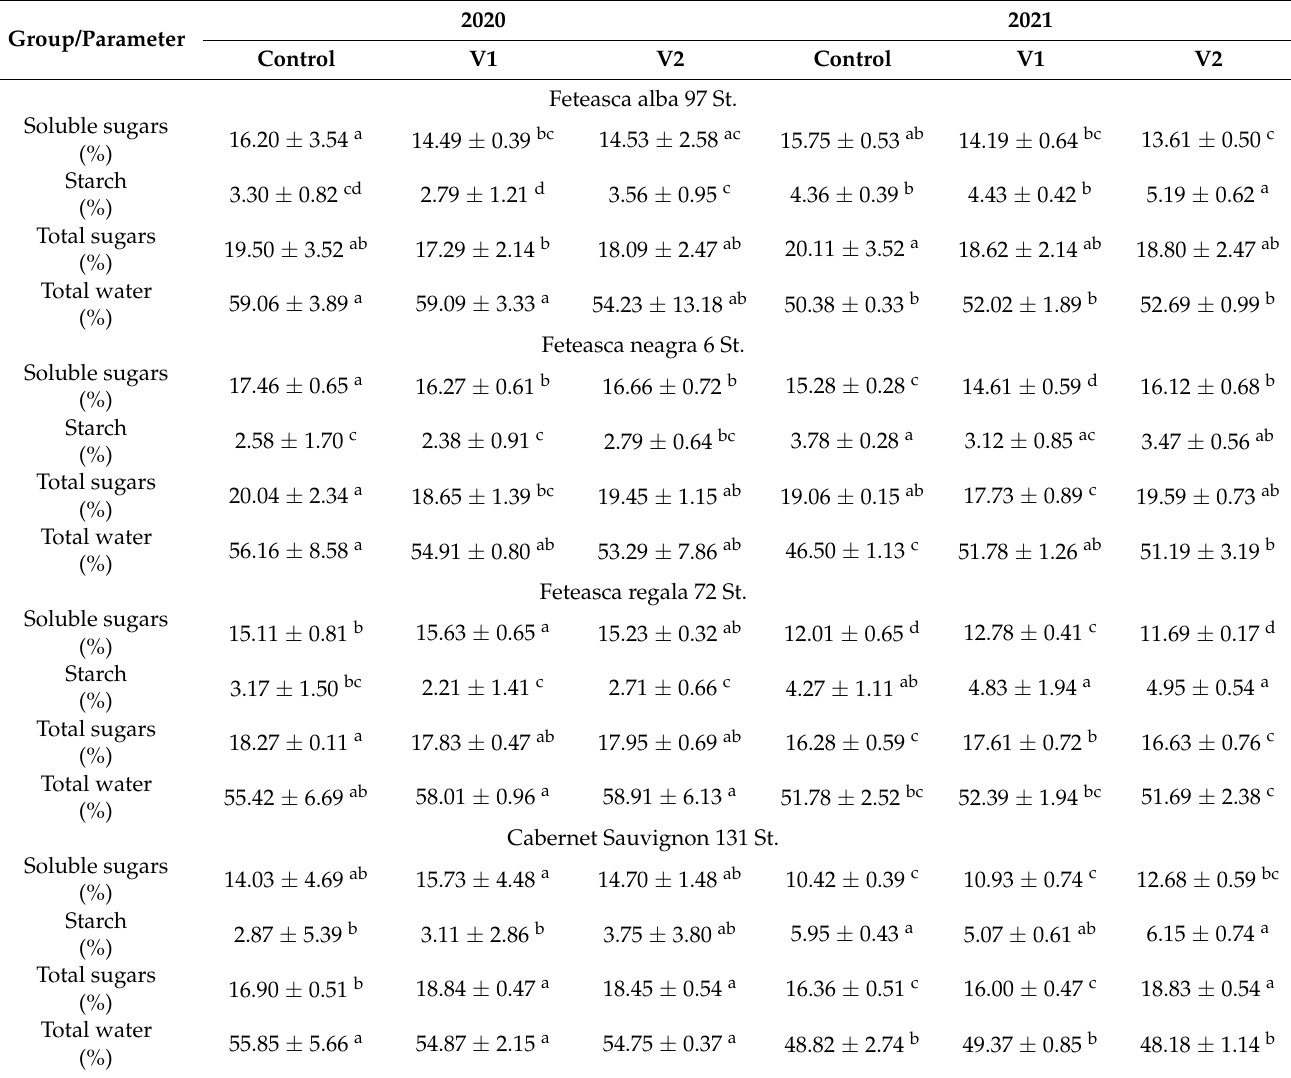
Table 3. Biochemical analyses at Feteasca alba 97 St., Feteasca neagra 6 St., Feteasca regala 72 St., Cabernet Sauvignon 131 St. plants. V1 = alcoholic extract of D. filix-mas , V2 = silver